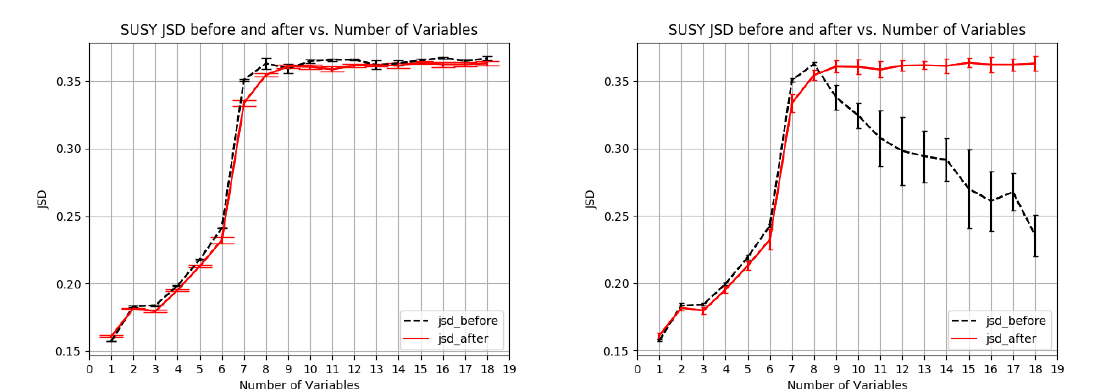
Figure 5. Comparison of MI values for increasing additions of discriminating variables for the SUSY data set. The first eight variables are low-level and the last ten are functions of the first eight. The first plot shows a comparison of (NN) performance when the last ten variables are redundant while the second shows how KSG’s accuracy deteriorates when the high-level variables are shuffled.